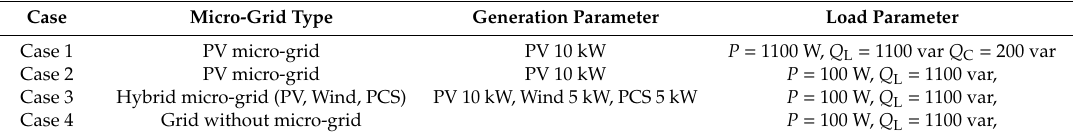
Table 2. Experimental system configuration.